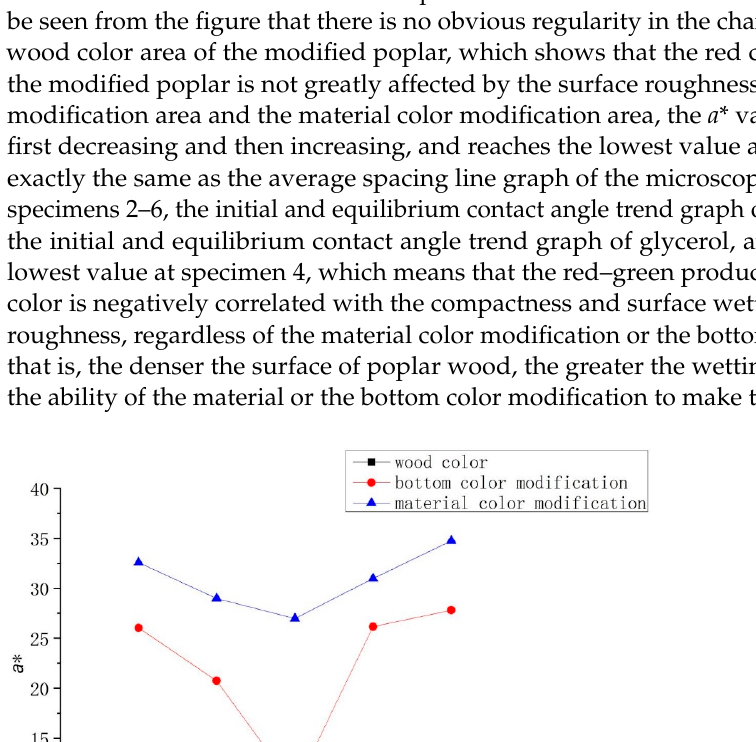
Figure 7. The effect of different surface disposition to b *. The color saturation parameter C * is the comprehensive effect of a * and b * values, as shown in Figure 8. It can be seen from the figure that the change in trend of the C * value in the bottom color modification area is similar to the a * value, which is due to the large change of a *. In the material color modification area, the C * value changes not signifi- cantly, because the a * and b * values are close to each other. The material of specimen 7 is mahogany. As a reference test piece, it is treated in the same way as that of specimen 5 in the pretreatment stage. As shown in Figures 2–4, you can see the following points by com- parison: the difference of the value of lightness L * in the wood color area is 13.34, in the bottom modification area is 8.326 and in the material modification area is 1.81, showing a gradual decrease. The small trend indicates that continuous coloring can reduce the light- ness gap between modified poplar and the mahogany coloring layer. The difference of a* value in the wood color area is 1.86, in the bottom modification color area it is 4.42 and in the material color modification area it is 1.33, showing a trend of increasing first and then decreasing. This shows that although the bottom color modification makes the red color value difference of the two woods larger, the material color correction operation has nar- rowed the gap, and it is smaller than the difference in the modified poplar’s own material